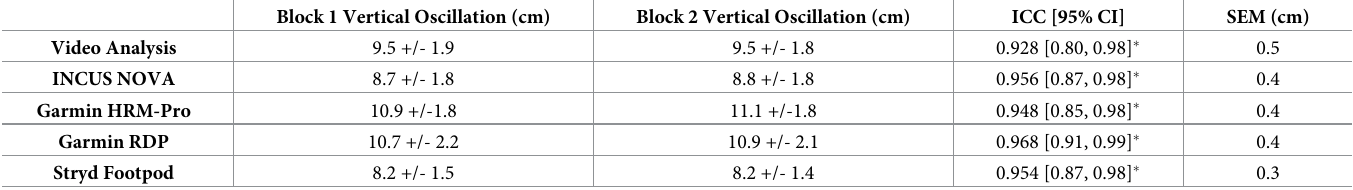
Table 1. Reliability between repeated vertical oscillation